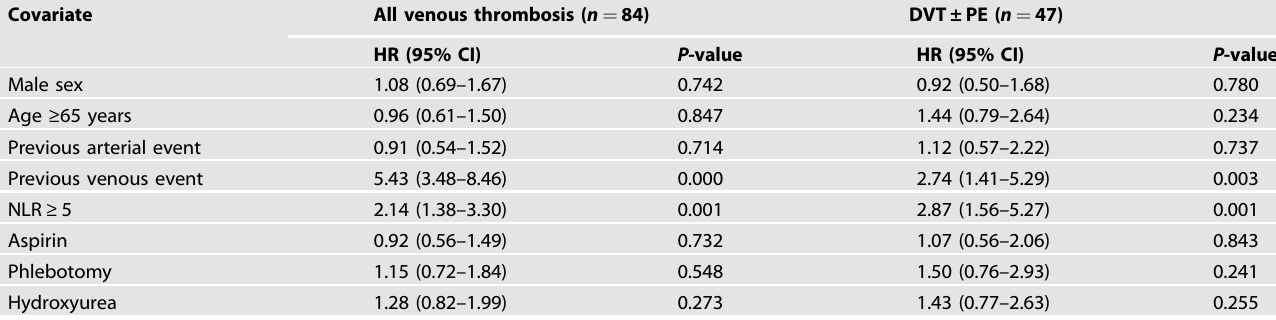
Table 3. Multivariable Cox proportional hazards models for the prediction of all venous thrombosis and deep vein thrombosis -with or without pulmonary embolism only.